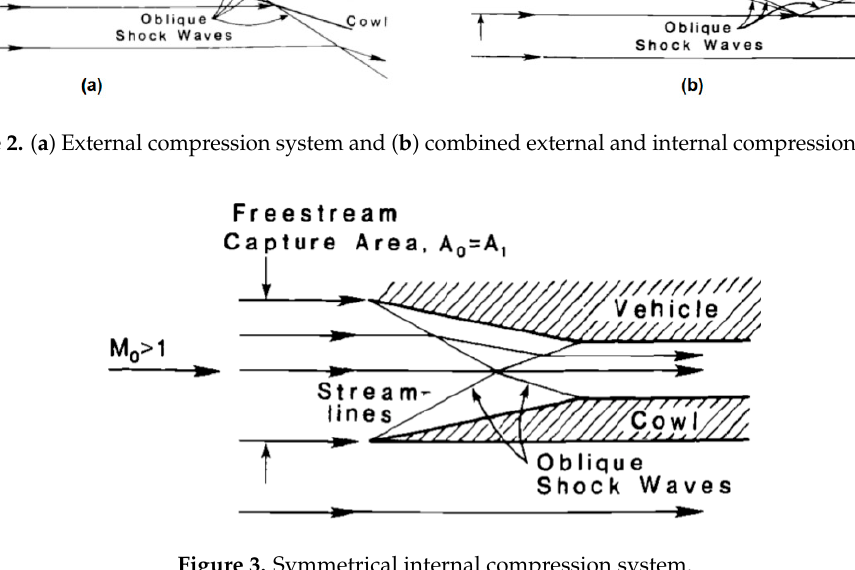
Figure 3. Symmetrical internal compression system.